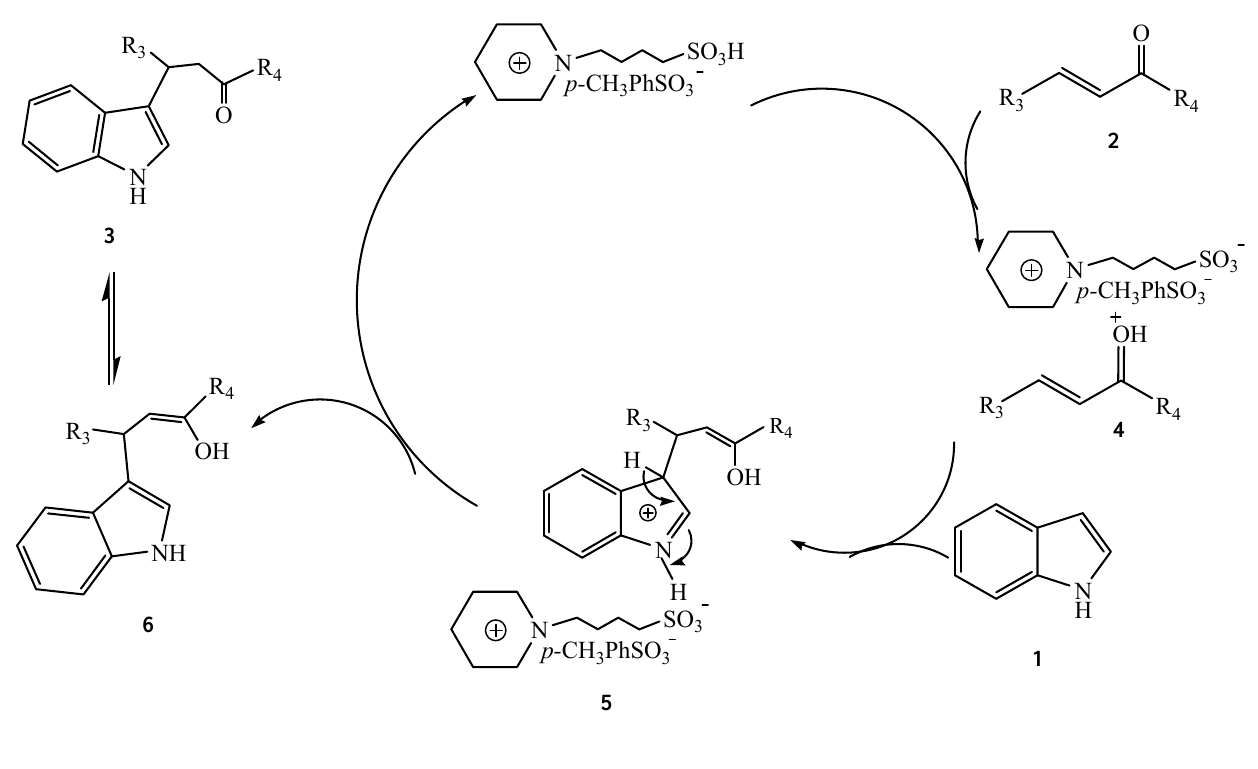
Reaction conditions : indole or substituted indoles (2 mmol), α , β -unsaturated ketones (2